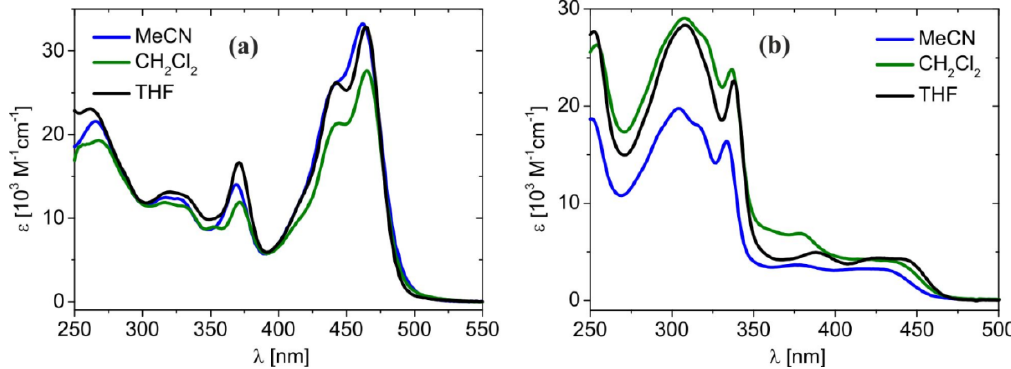
Figure 5. Electronic absorption spectra of complexes 1 ( a ) and 2 ( b ) in different